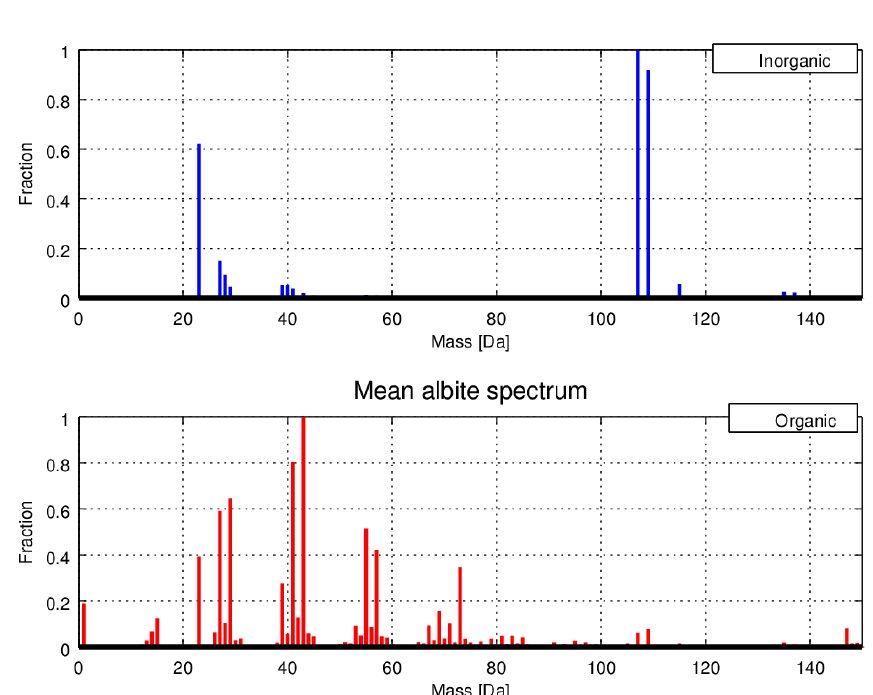
Figure 3. Example of peak lists. This is the average of peak lists for albite spectra. Organic and inorganic components are